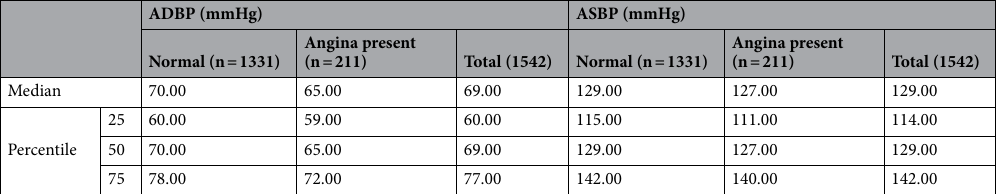
Table 2. Median and percentile values of ADBP and ASBP. ADBP: average diastolic blood pressure; ASBP: average systolic blood pressure.